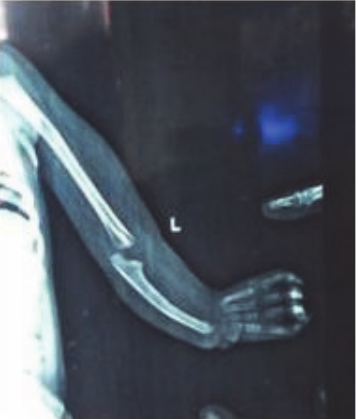
Figure 1: Facial features show bifrontal prominence, high forehead, left epicanthal fold, depressed and broad nasal bridge, upturned nares, prominent philtrum, thin upper lip, and bilateral low set ears.